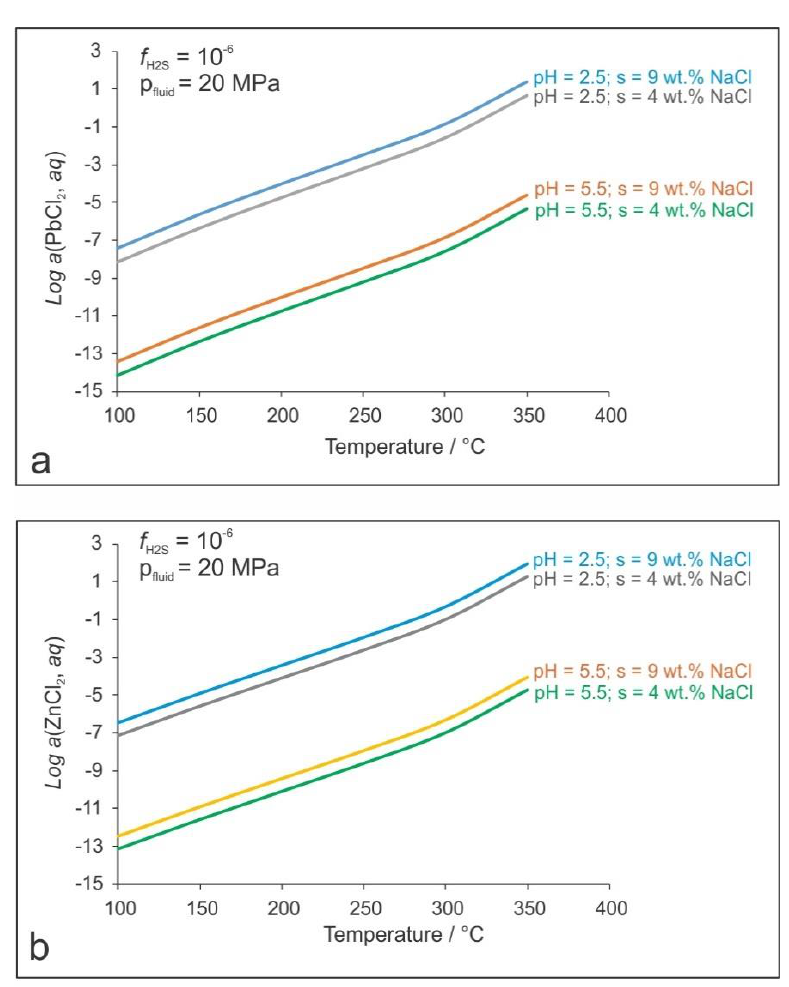
Figure 16. ( a ) Solubility of Pb as a function of temperature, pH, and the fluid salinity; ( b ) Solubility of Zn as a function of temperature, pH, and the fluid salinity (s). The H 2 S fugacity ( f H2S ) has been fixed as 10 − 6 and the total pressure (p fluid ) as 20